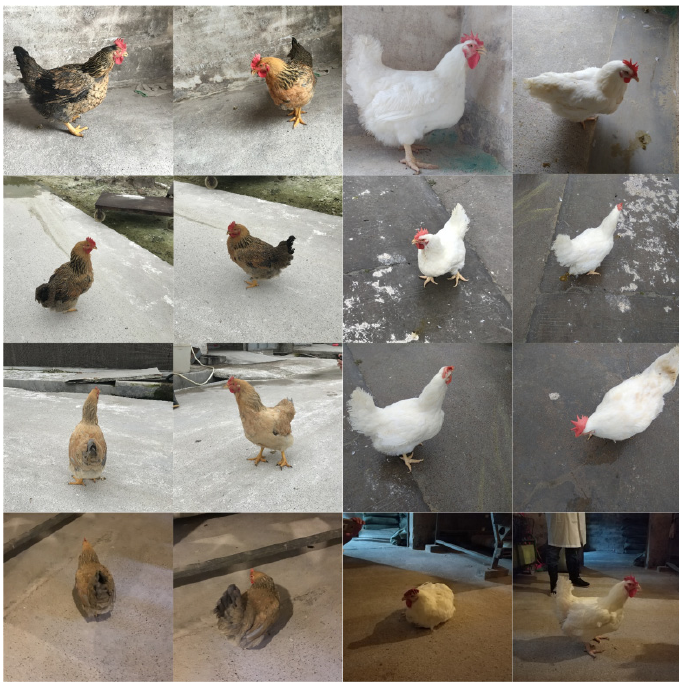
Figure 1. Experimental environment and test object.